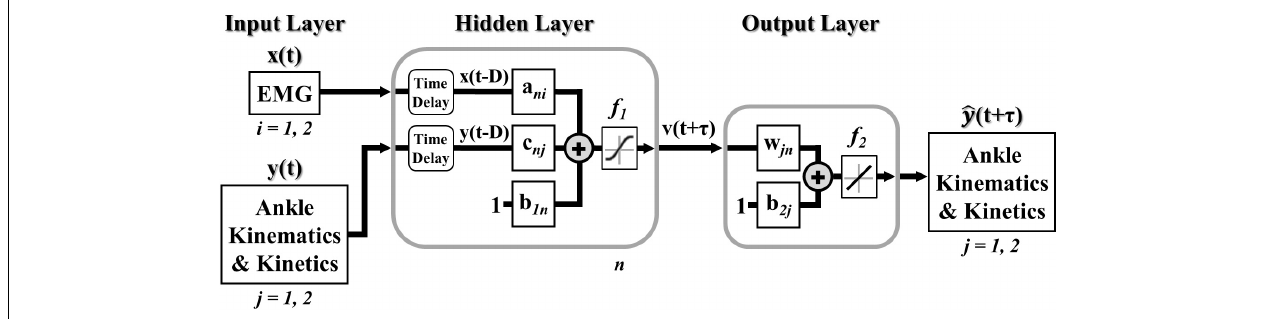
FIGURE 2 | Multiple-input multiple-output feedforward (open-loop) NARX model. EMG linear envelopes (ankle dorsiflexor and plantarflexor) and experimentally measured values of ankle angle and ankle moment were weighted and fed via tapped delay lines to a single hidden layer containing nonlinear units with hyperbolic tangent sigmoid transfer functions. Intermediate outputs were weighted and linearly combined to provide continuous and simultaneous predictions of future ankle angle and moment over time.